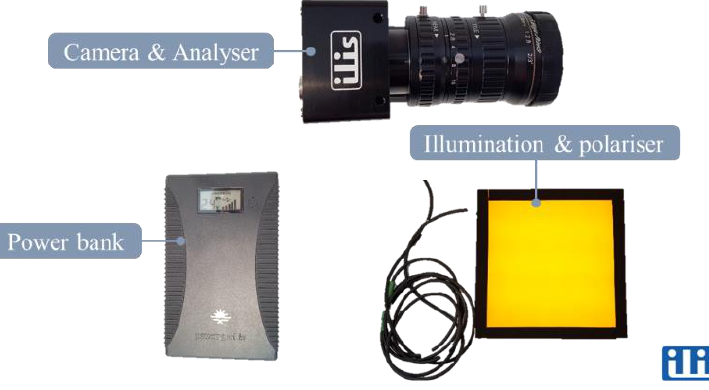
Fig. 6 Components of the mobile measuring